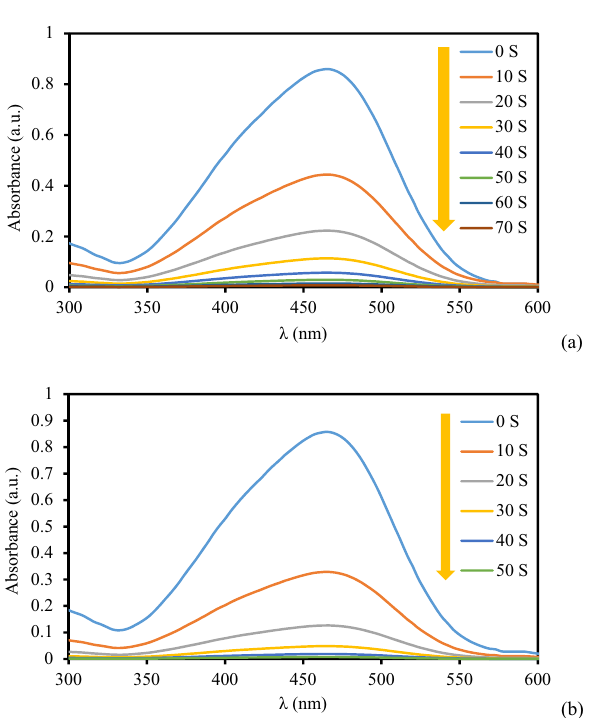
Figure 9. The absorption profile in the reduction of MO using 2 mg ( a ) and 3 mg ( b ) of KIT-5- biguanidine-Au(0)